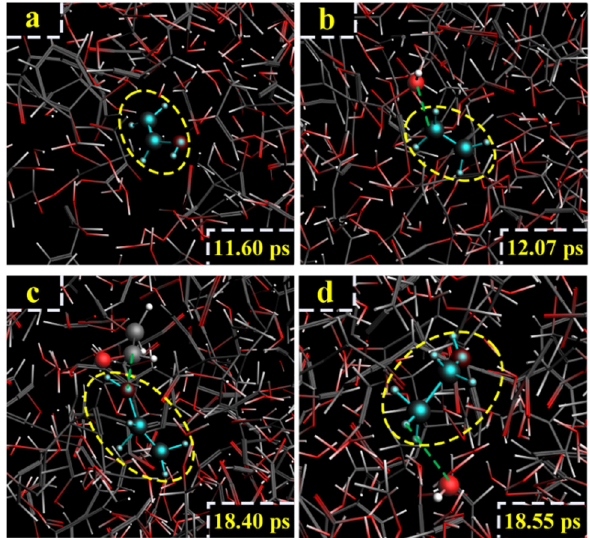
Figure 21. Path VI for the production of ethanol. ( a – d ) are the procedure of LGA to produce ethanol at 3000 K.